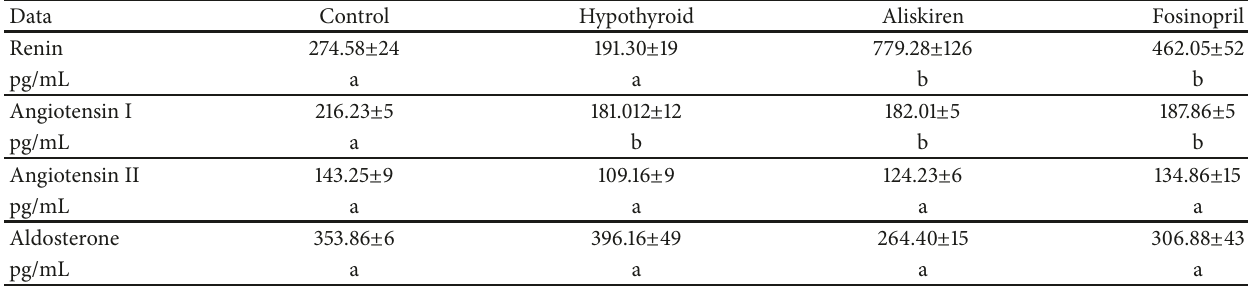
Table 3: Effects of hypothyroidism, Aliskiren, and Fosinopril on serum levels of renin, angiotensin I & II, and aldosterone.